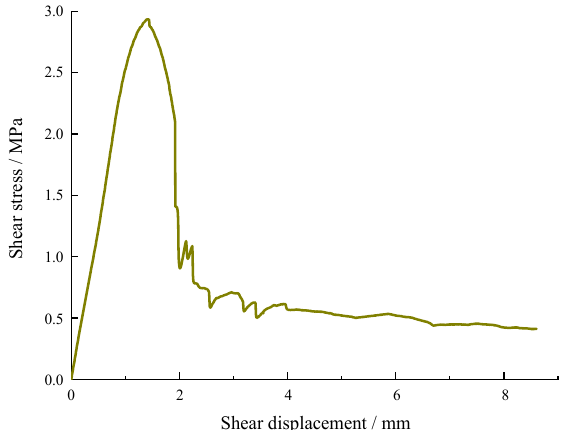
Figure 7. Shear stress–shear displacement curve from the direct shear test [70].